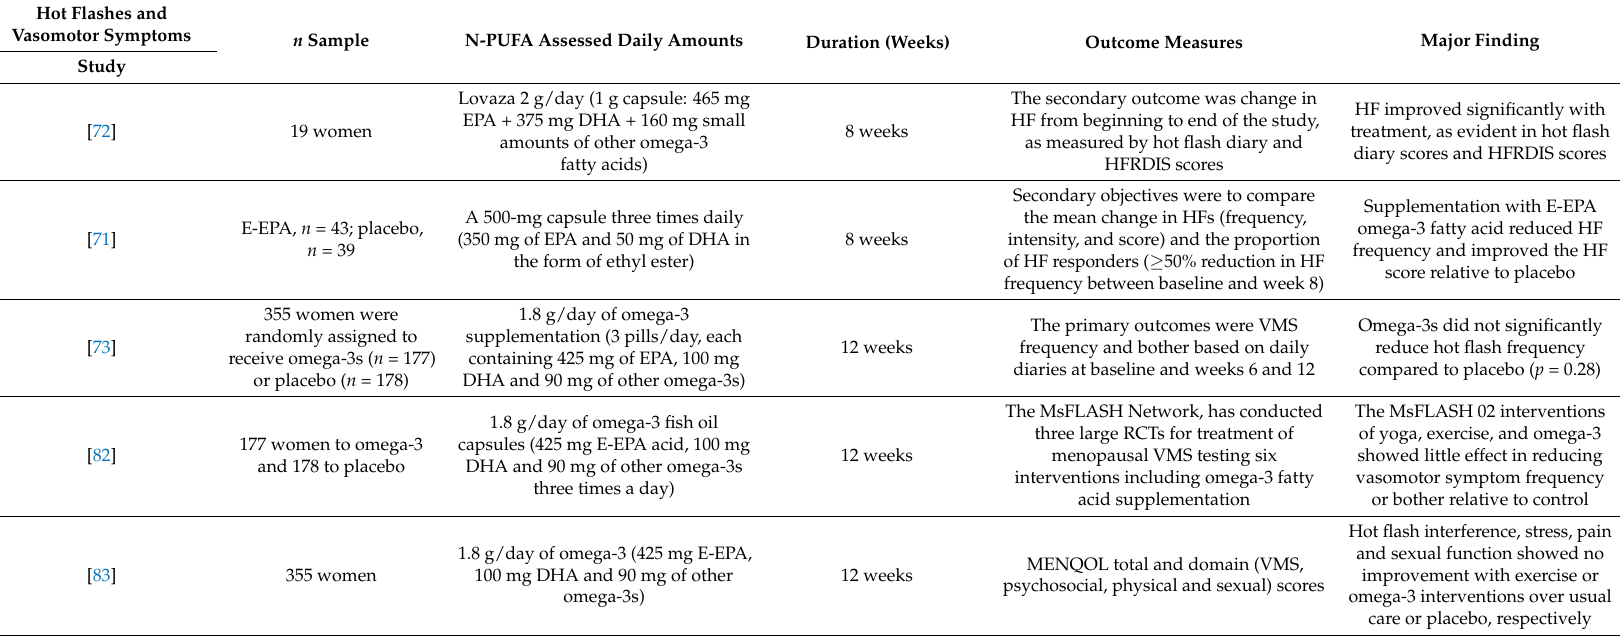
Table 2. RCTs of n-3 LCPUFAs in menopausal hot